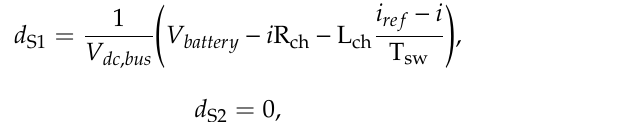
Figure 2. The bidirectional half-bridge DC-DC converter. Reprint with permission [29]; 2020, IEEE.